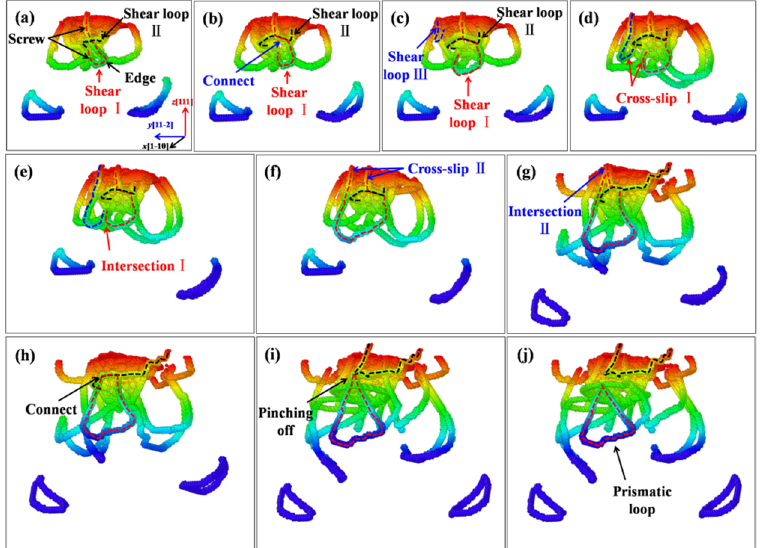
Figure 14. Formation of prismatic loops based on “nested-loops” mechanism for indentation on (111) plane, with colors scale from red to blue indicating depth from sample surface. The dash lines depict the related shear loops for formation of the prismatic loop. ( a – c ) The nucleated shear loop I, II, and III, respectively. ( d ) Screw components of shear loop I and III start to cross-slip. ( e ) Shear loop I and III glide to the same position. ( f ) Cross slip of shear loop II and III. ( g ) Intersection of shear loop II and III. ( h ) Merging of shear loop II and III. ( i ) The merged dislocation loop starts to break away from the indented area. ( j ) The emitted prismatic loop.